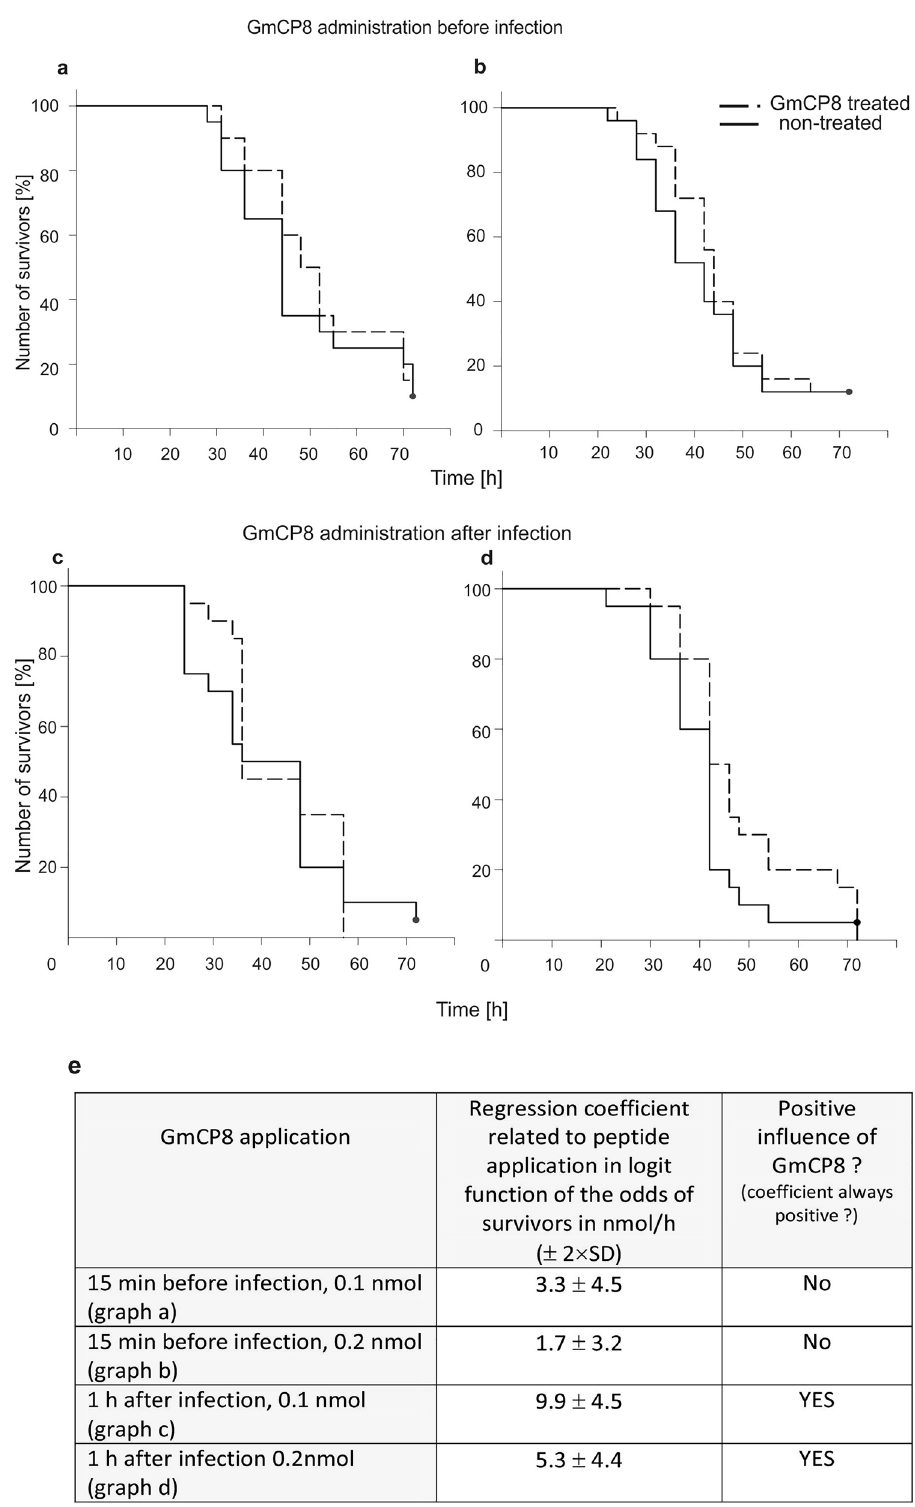
Figure 7. Kaplan-Maier survival curves of G. mellonella larvae after intrahemocelic administration of 0.1 nmol ( a and c ) and 0.2 nmol ( b and d ) of GmCP8 (treated larvae) and water (non-treated larvae) 15 min before ( a and b ) and 1 h after ( c and d ) injection of P. entomophila . In ( b )—the groups comprised 25 larvae each; in: ( a , c , d ) the groups comprised 20 larvae each. ( e ) result of the binomial regression analysis of each experiment ( a – d ) with respect to the effect of GmCP8 in comparison to the application of water. Regression coefficients related to the peptide application in the logit function of the odds of survivors is positive (above 0) in each case; taking into consideration the standard deviation (± 2 SD), the positive effect of GmCP8 on the infected larvae was statistically confirmed, when GmCP8 was applied 1 h after the administration of